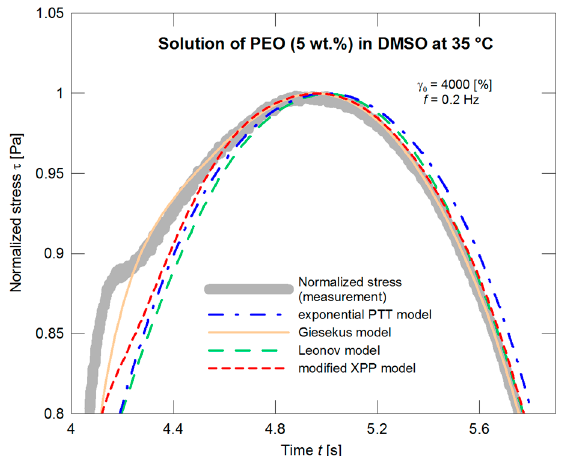
Figure 9. A description of normalized stress by the exponential PTT, Giesekus, Leonov, and modified XPP models using the nonlinear parameters optimized with respect to the steady shear viscosity measurements (Figure 4), the detail with the “protrusion” region.